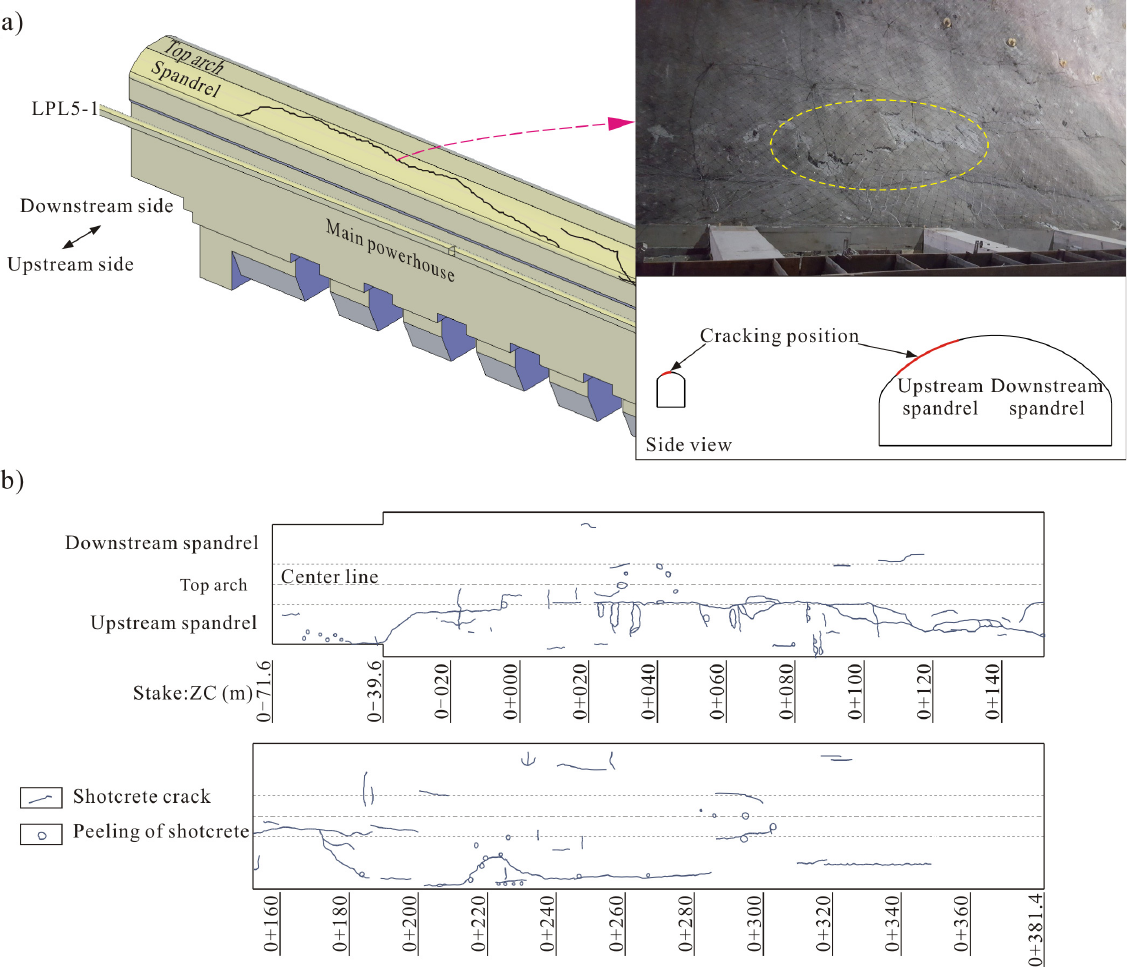
Figure 10. Shotcrete failure at the arch of the main powerhouse: ( a ) location and photo of shotcrete crack and ( b ) a distribution diagram of shotcrete failure.